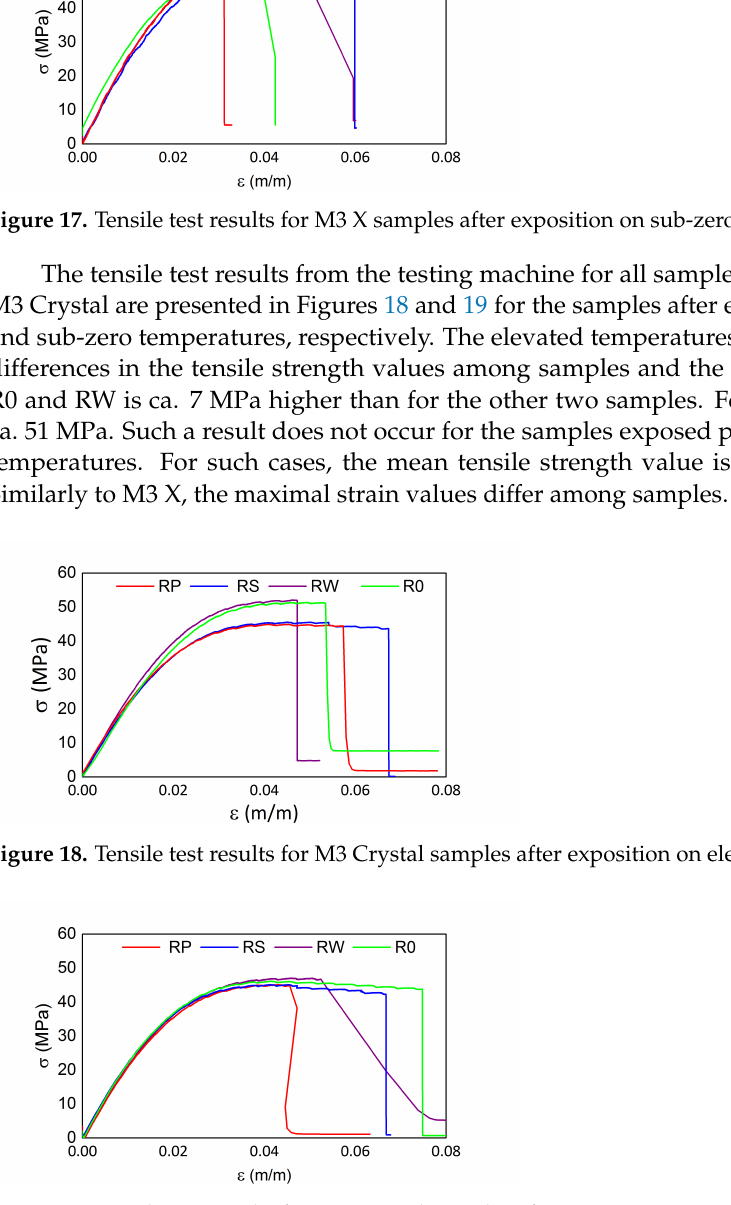
Figure 19. Tensile test results for M3 Crystal samples after exposition on sub-zero